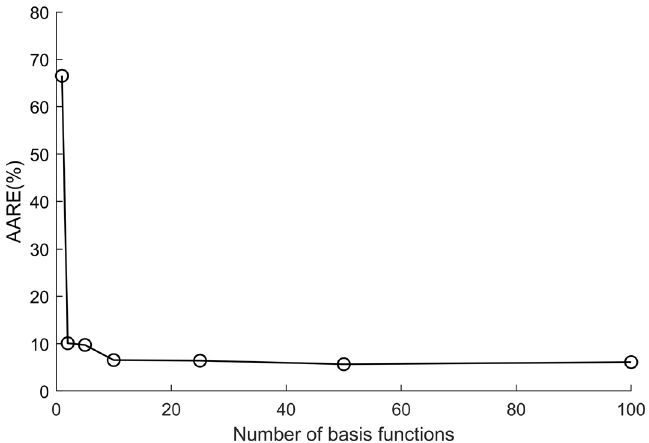
Figure 3. The relationship between the AARE on the testing dataset and the number of basis functions